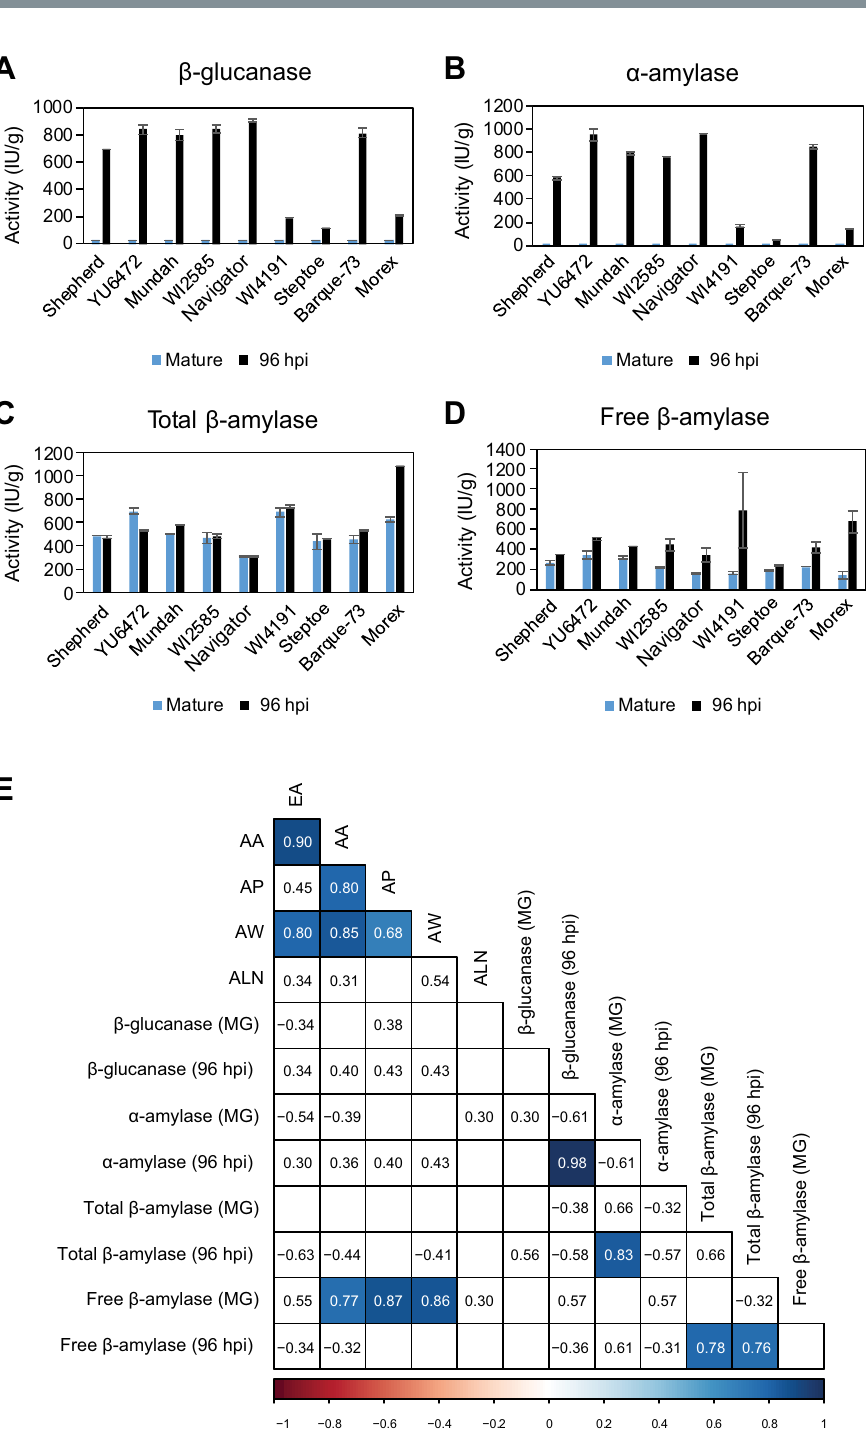
Figure 4. Hydrolytic enzyme activities in grain from nine barley genotypes at grain maturity and 96 hours post imbibition (hpi). ( A ) 1,3;1,4- β -glucanase ( β -glucanase) activity. ( B ) α -amylase activity. ( C ) Total β -amylase activity. ( D ) Free β -amylase activity. Error bars show standard deviation. ( E ) Heat map representing correlations between aleurone measurements and enzyme activities for the nine different genotypes. Note, some aleurone correlation values differ to those in Fig. S5 due to the different sample size. Blue boxes indicate positive correlations. Numbers within boxes represent correlation coefficient ( r ) values. All values > 0.3 or < − 0.3 are shown, but only those with a p-value ≤ 0.05 are contained within shaded boxes. MG, mature grain; EA, endosperm area; AA, aleurone area; AP, aleurone proportion; AW, aleurone width; ALN, aleurone layer